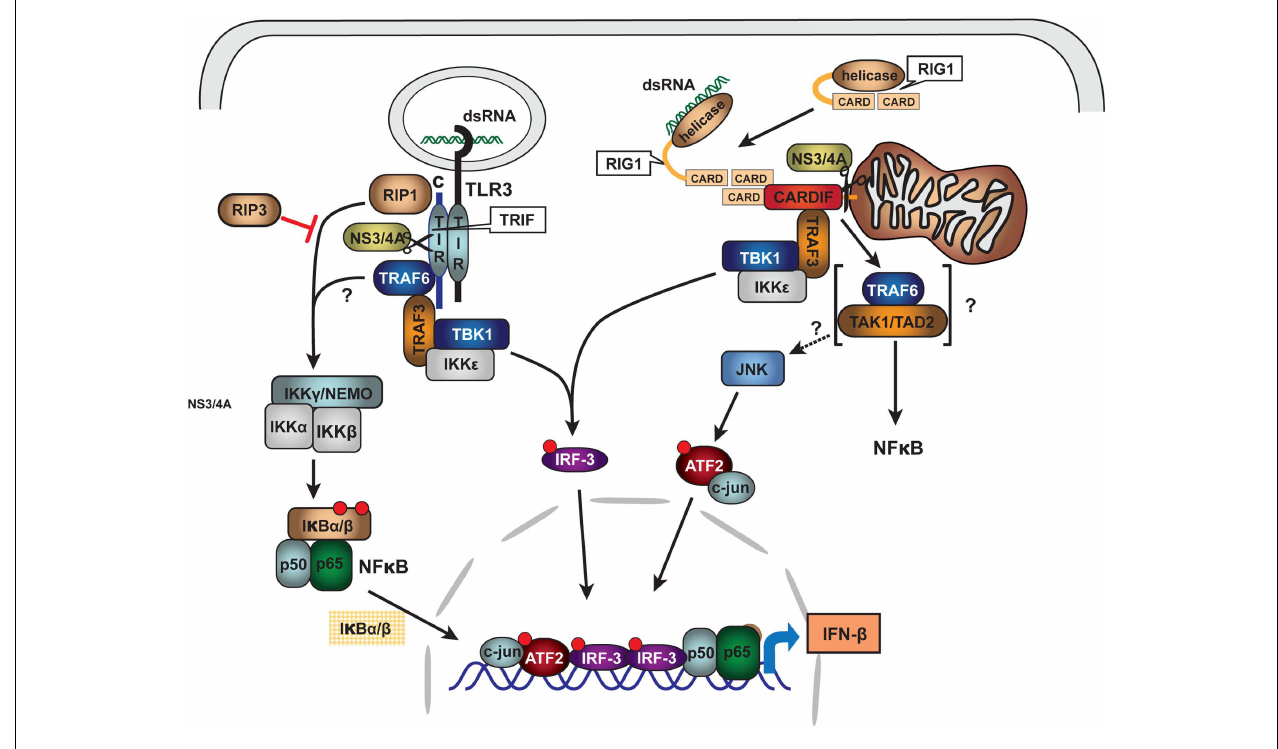
intermediate steps of recognition, binding, and phosphorylation leading to activation of the transcriptional factors IRF3 and NF κ B.The activated nuclear transcription factors bind to type I interferon promoters and induce α / β -interferon transcription. HCV NS3/4A protease is known to cleave bothTRIF and CARDIFF adapters thus crippling innate immune antigen recognition and signaling for type I interferon induction.With permission (Bode et al., 2007), see original review for terminology and